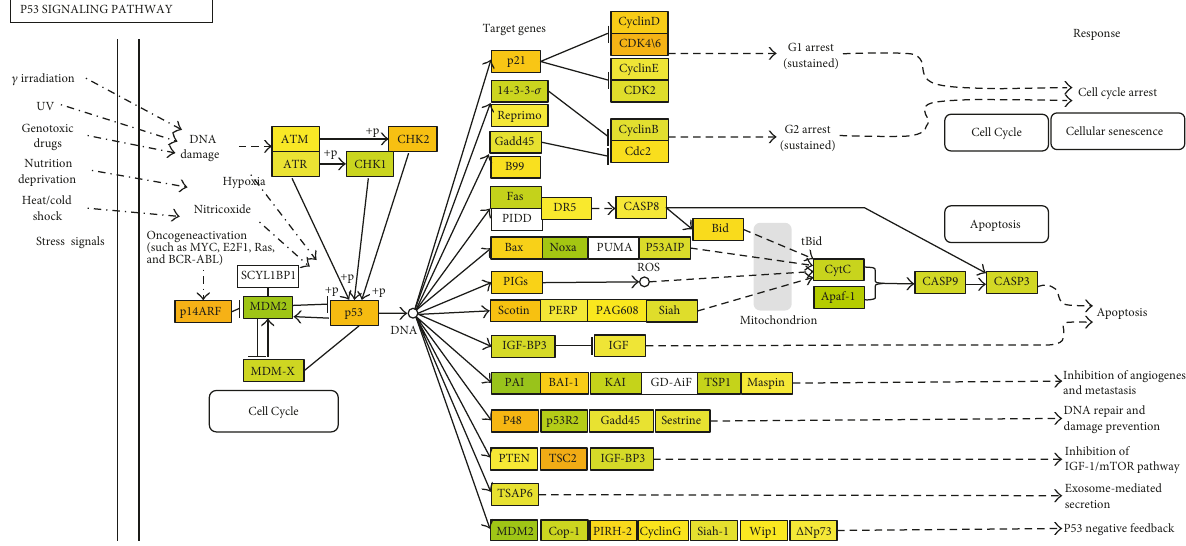
Figure 4: p53 signaling pathway and related signi fi cant changes observed in response to postprandial serum (orange: upregulated compared to fasting serum; green: downregulated compared to fasting serum).